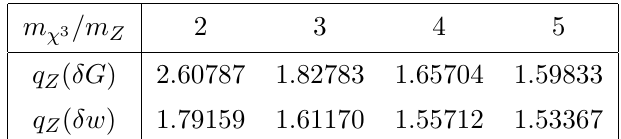
Table 1 . The obtained values of q Z by (cid:12)tting the solution of the (1 ; 0) string. q Z ( (cid:14)G ) and q Z ( (cid:14)w ) denote the one using the asymptotic forms of (cid:14)G (eq. (3.31)) and (cid:14)w (eq. (3.30)), respectively. There is a good agreement between them for larger m the approximate expressions (3.30) and (3.31) are not valid for smaller m